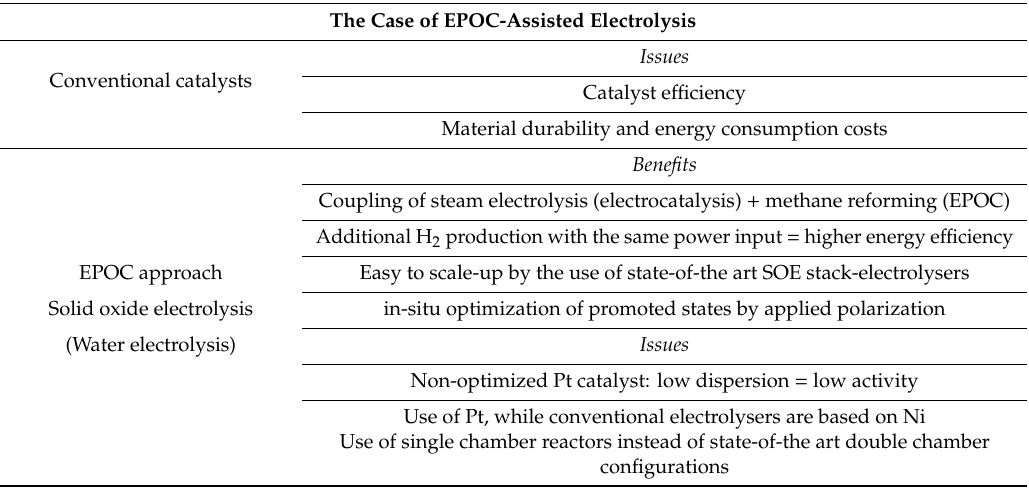
Table 4. Main issues and benefits of the EPOC-assisted water and methanol